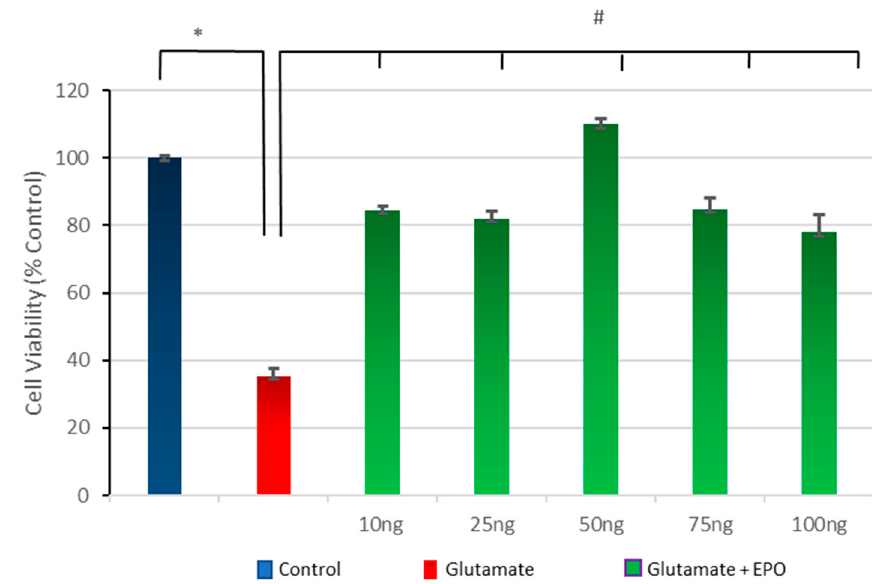
Figure 3. Neuroprotective effect of neuroEPO against glutamate-induced neuronal death. Cortical cells were treated with glutamate for 15 min, followed by treatment with various concentrations of neuroEPO (25, 50, 100, and 150 ng/mL medium) for 24 h. Treatment with glutamate induces a significant ( p < 0.005) loss of the viability of the neurons compared with the loss of viability of the neurons not treated with glutamate (control). The treatment with neuroEPO significantly ( p < 0.005) decreases the loss of viability induced by glutamate. The results are expressed as percentages, considering the control as 100%. Data are the mean ± SEM values from n = 3 independent experiments; * p ≤ 0.005; # p ≤ 0.005.